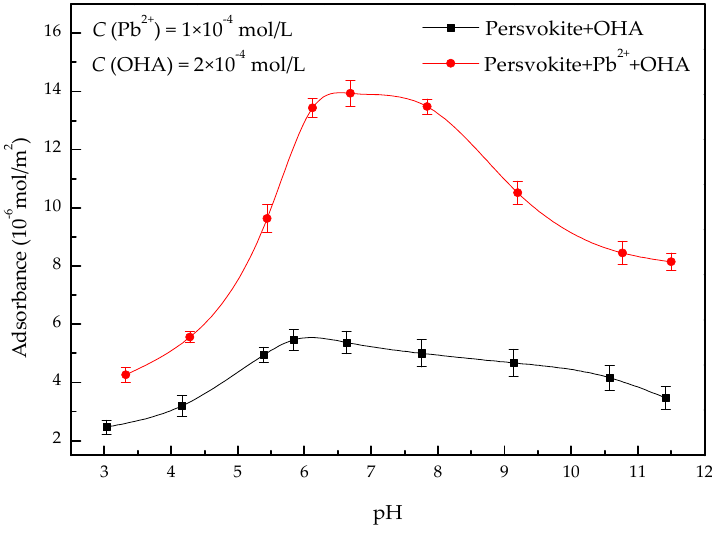
Figure 7. OHA adsorbance on the surface of perovskite as a function of pH.